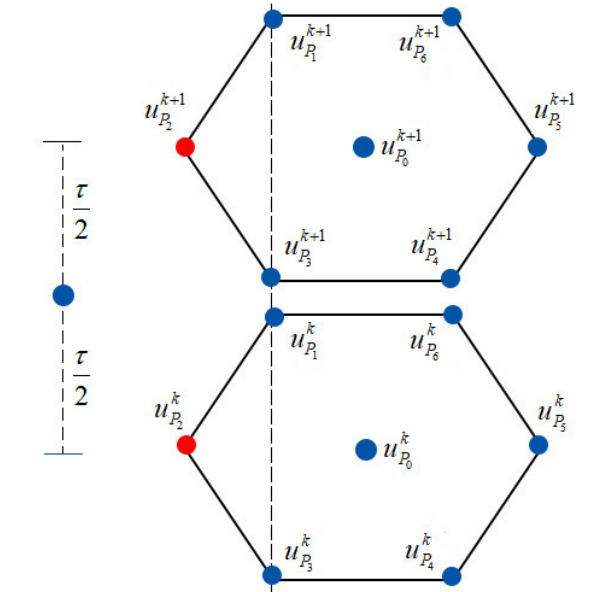
on the left ghost points at time moments t = k τ and ( k + 1 ) τ ,